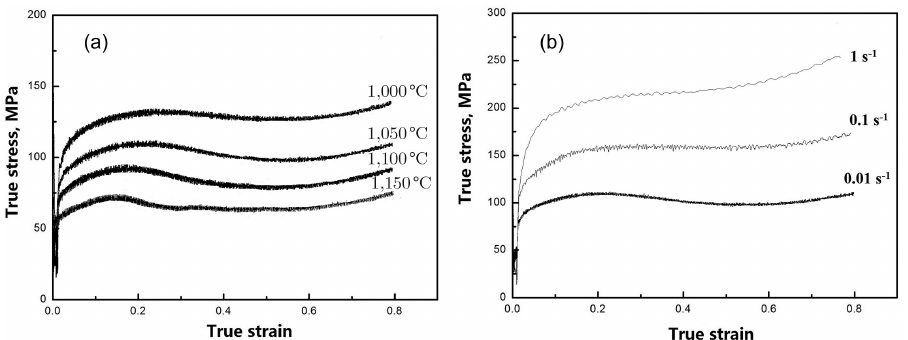
Figure 3: Flow stress curves of alloy 800H at different deformation conditions: (a) 0.01 s – 1 and (b)